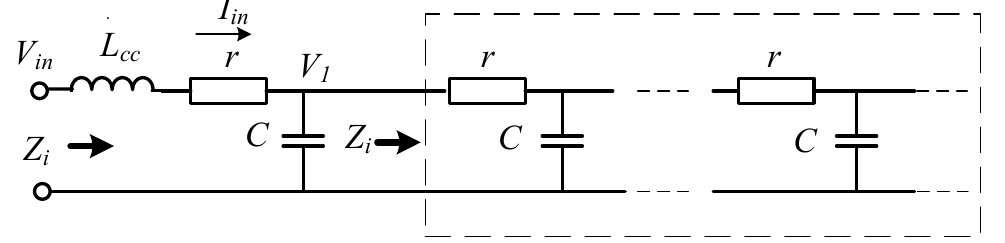
Figure 6. Modified equivalent circuit of the ultracapacitor. The component, L cc, represents the inductivity of connection wires.